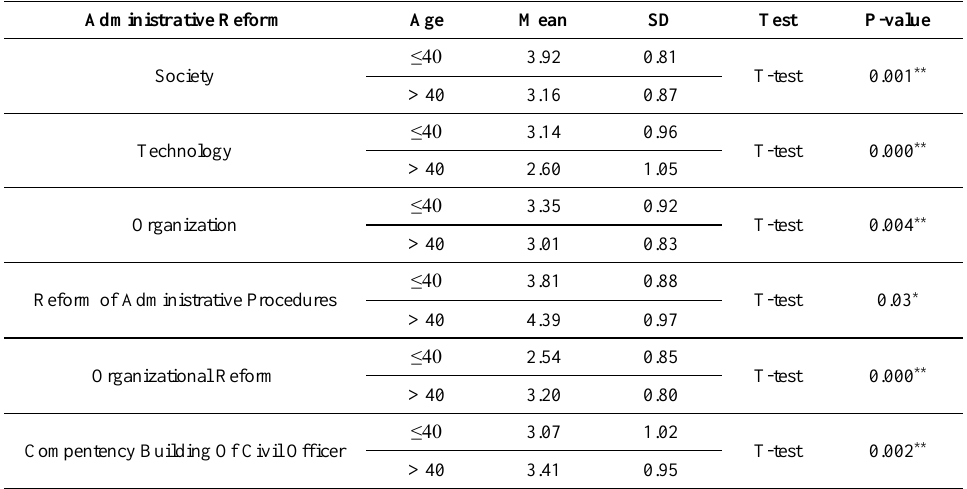
Table 5. Digital transformation and administrative reform by age variable